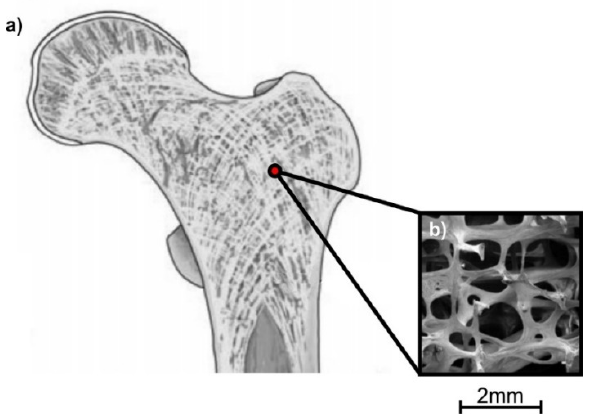
Figure 3. Trabecular bone: ( a ) trabecular bone schematic [36]; ( b ) trabecular/Voronoi-like structure examined by scanning electron microscope (SEM) [37].